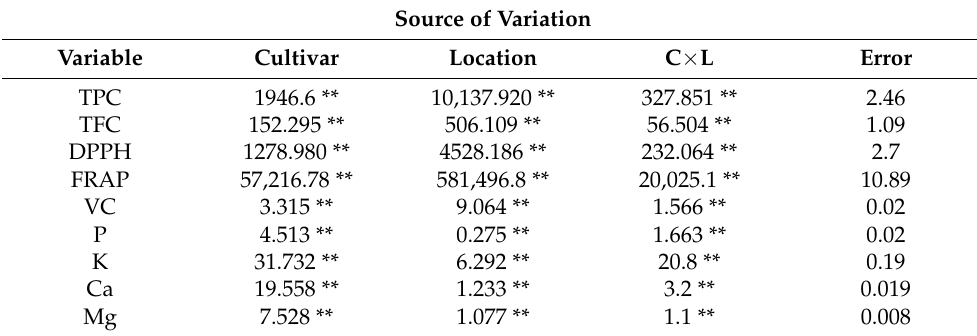
Table 1. Mean analysis of antioxidant activity and mineral contents of unripe apple fruits based on cultivars in the locations.